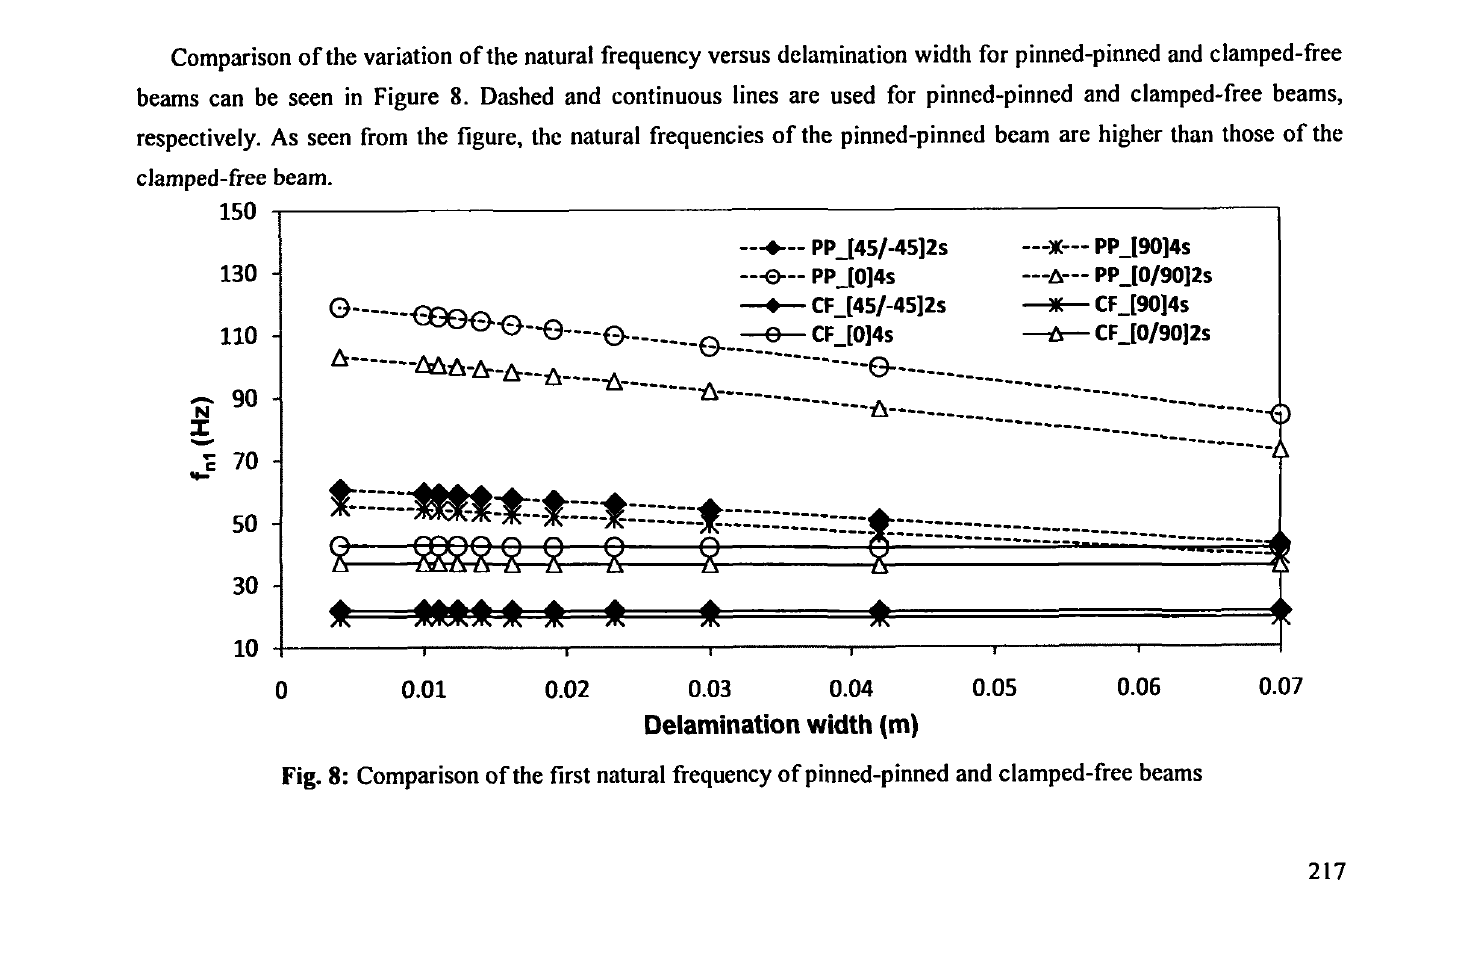
Fig. 8: Comparison of the first natural frequency of pinned-pinned and clamped-free